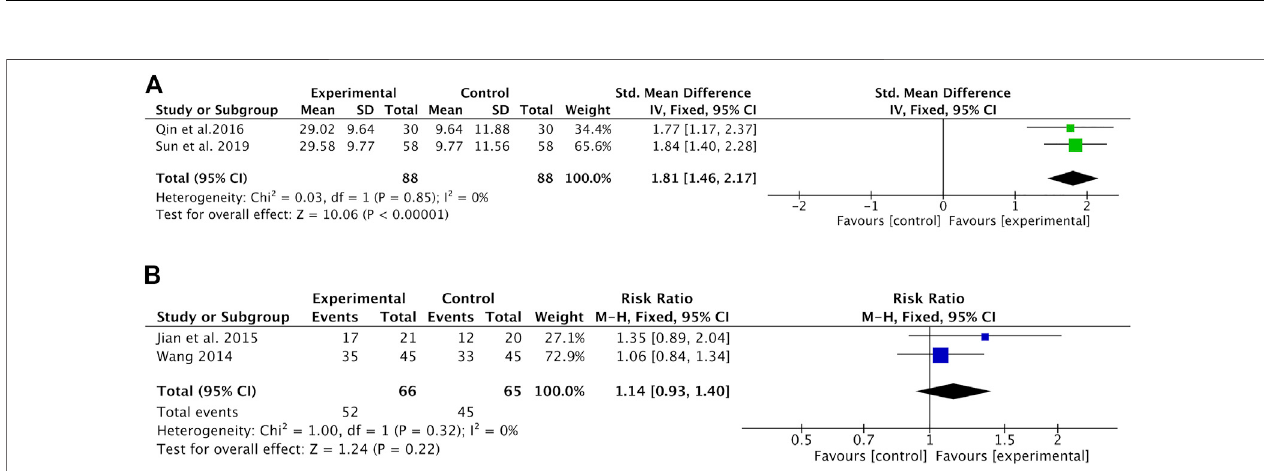
FIGURE 3 | Forest plot of tumor response (CR + PR) of Astragalus-containing CHM combined with CT vs. CT alone. CHM, Chinese herbal medicine; CT, chemotherapy; CR, complete response; PR, partial response.